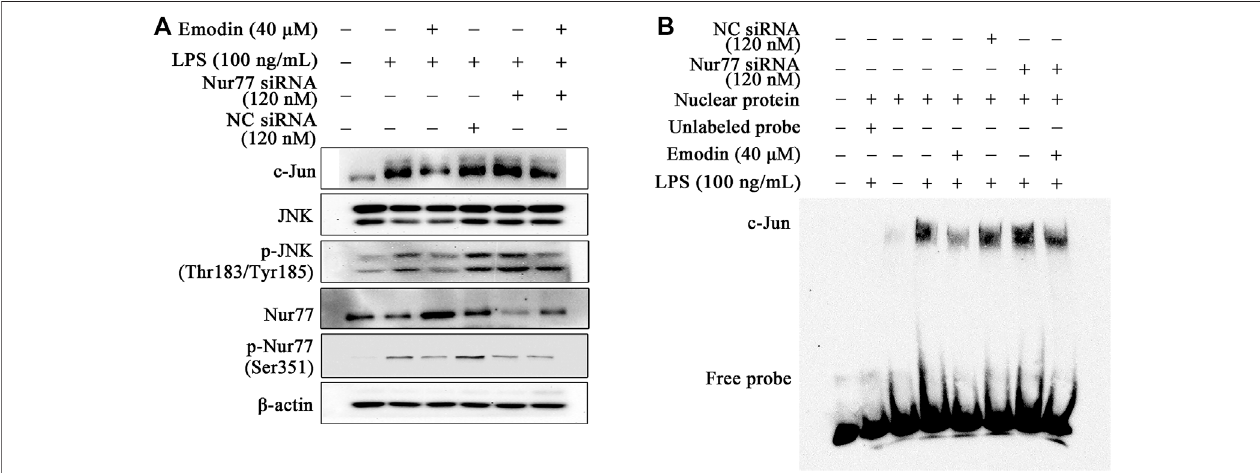
FIGURE 4| Emodin suppresses LPS-induced activation ofc-Jun through regulation ofNur77. (A) Emodin decreases the expression levels ofp-c-Jun (Ser73) and c-Jun through regulation of Nur77. RAW264.7 cells were transfected with Nur77 siRNA (120 nM) for 24 h, and then treated with emodin (40 μ M) for 2 h, followed by exposure to LPS (100 ng/ml) for another 18 h, p-c-Jun (Ser73), and c-Jun were detected by Western blotting. (B) Emodin inhibits the DNA-binding activity of c-Jun through regulation of Nur77. The nuclear lysates were harvested and the DNA-binding activity were measured using